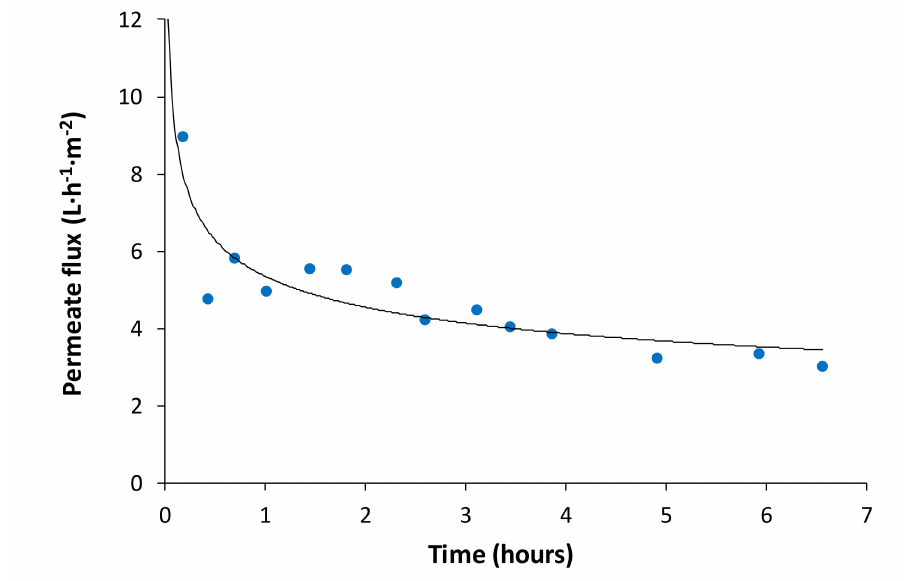
Figure 7. Permeate flux versus time in the forward osmosis